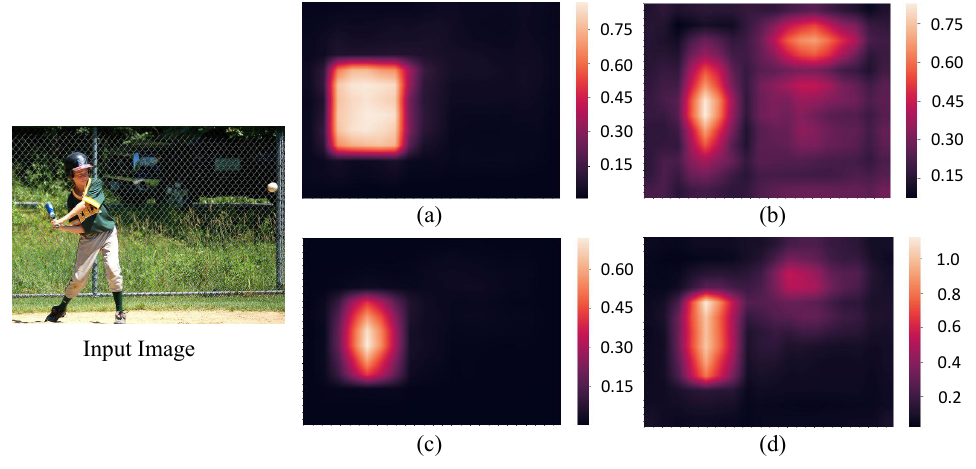
Figure 5. The visualization of classification confidence scores with different weight distributions. The left shows input image. ( a ) Shows the original classification confidence scores without weight assignment. ( b ) Shows the weight distribution of centerness. ( c ) Shows the classification confidence scores with weight distribution of centerness. ( d ) Shows the classification confidence scores with our proposed attention